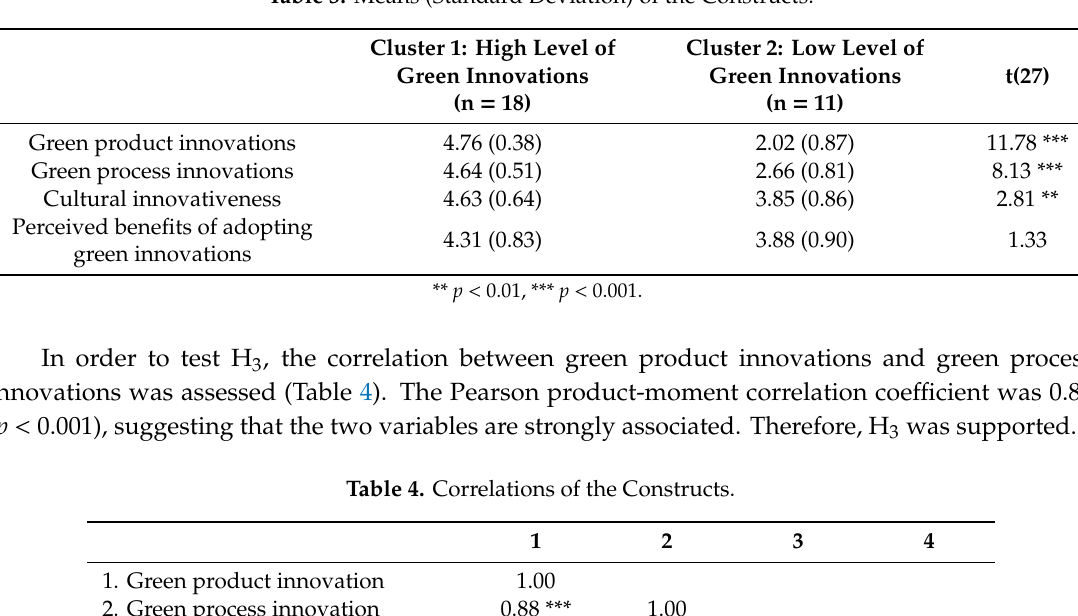
Table 3. Means (Standard Deviation) of the Constructs.